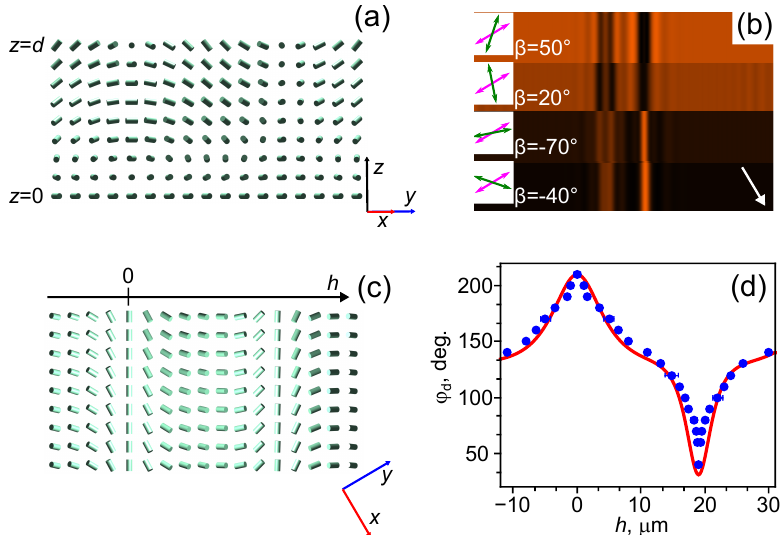
Figure 7. Calculated director configuration in the section perpendicular to the cell substrates and lines of defect ( a ); Simulated POM image of the area with couple of defects at different values of β angle between the analyzer and rubbing direction ( b ); The director orientation near the defect on the substrate covered with PiBMA ( c ); The theoretically calculated (solid line) and experimentally measured (points) dependences of the azimuthal angle of director rotation ϕ d on the distance h from the center of the left domain line ( d ). The polarizer is perpendicular to the rubbing direction on the simulated POM image. LC layer thickness is 6.5 µ m and confinement ratio is d / p =